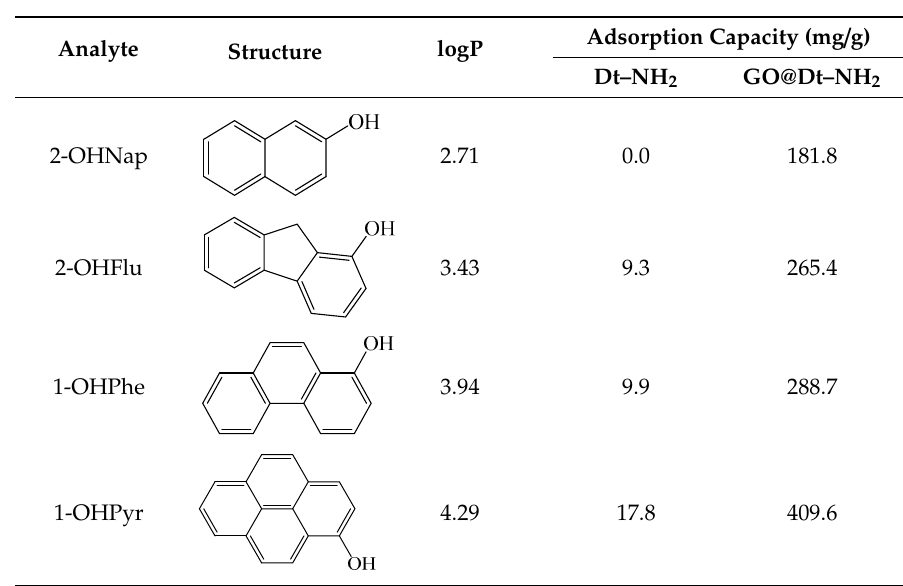
Table 1. The structure and logP values of the OH-PAHs and the adsorption capacities of Dt–NH 2 and GO@Dt–NH